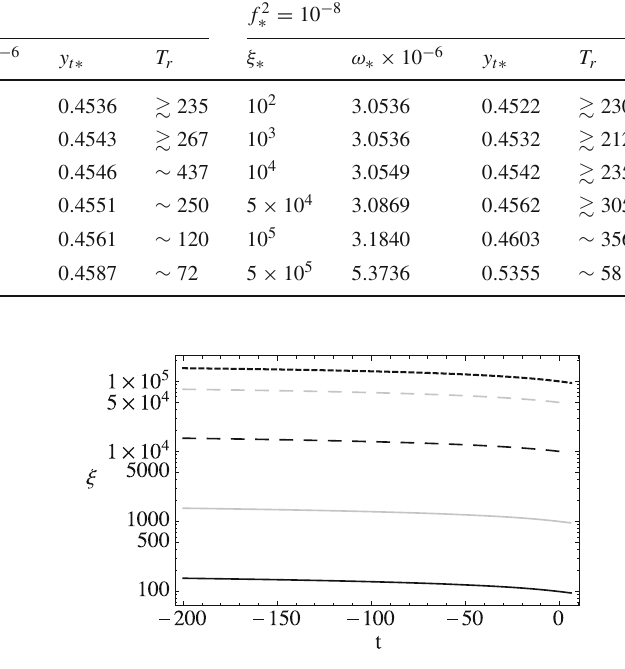
As ξ ∗ increase, the value of ω ∗ and y t ∗ increase. The number of e-folds tend to decrease as ξ ∗ increases. For smaller ξ ∗ the reason we see less e-folds is due to numerical precision of machine